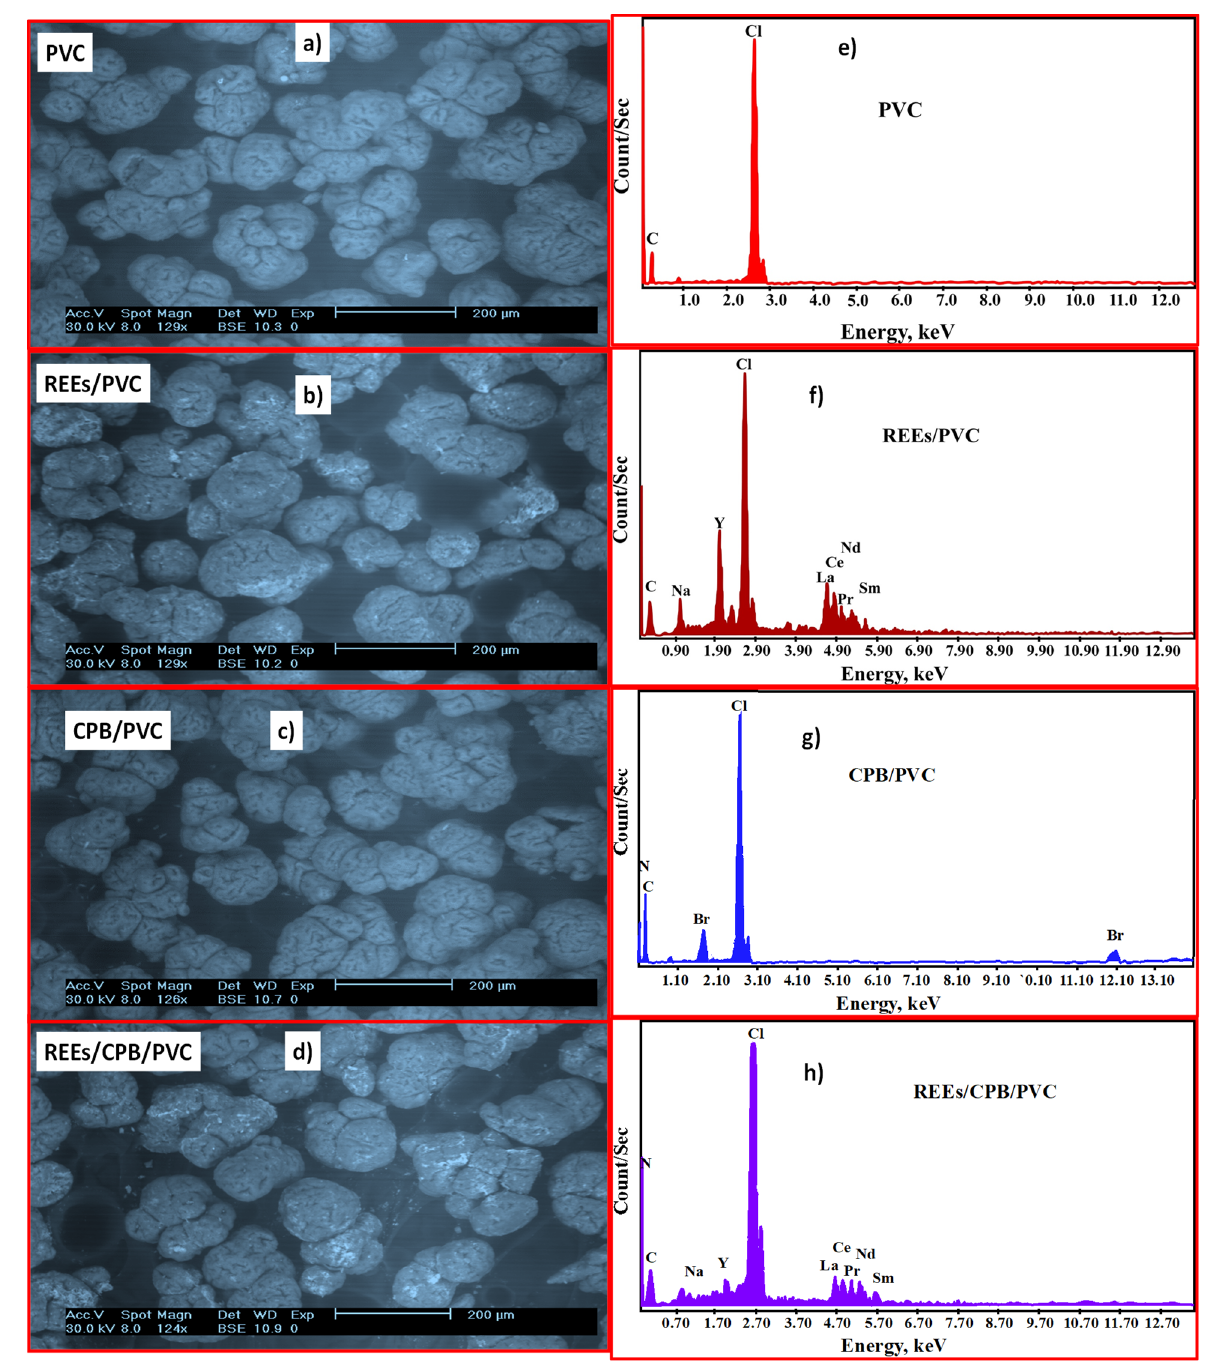
Figure 2. SEM pictures of ( a ) PVC, ( b ) REE/PVC, ( c ) CPB/PVC, ( d ) REE/CPB/PVC and EDX investi- gation of ( e ) PVC, ( f ) REE/PVC, ( g ) CPB/PVC, ( h )